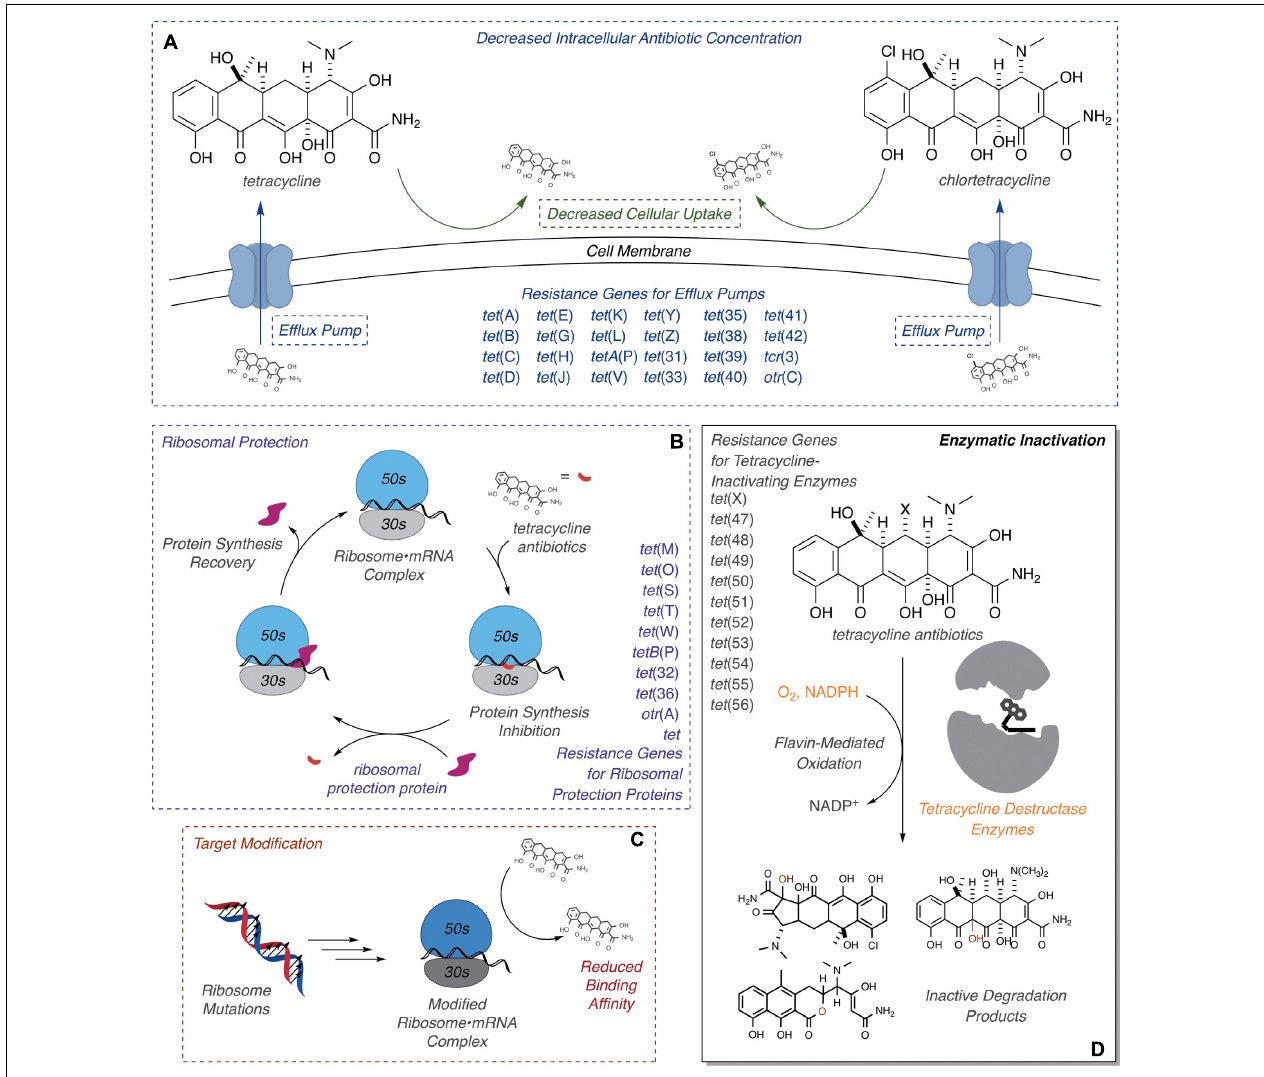
FIGURE 2 | Molecular mechanisms of tetracycline resistance. (A) Efflux, exclusion, (B) ribosome protection, (C) ribosome modification, and (D) enzymatic inactivation. Documented ARGs associated with each type of tetracycline resistance are